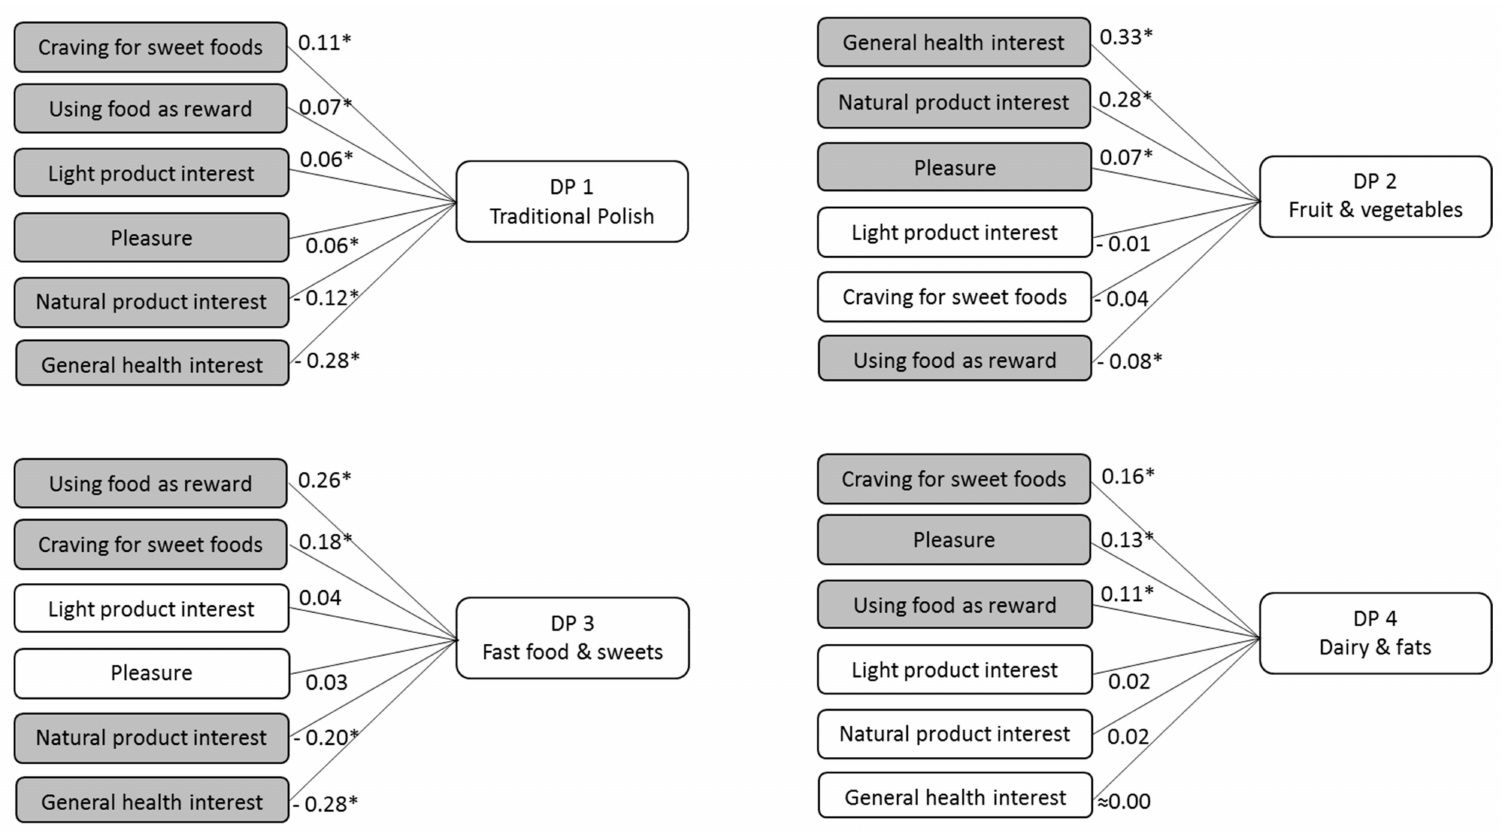
Figure 1. Spearman’s correlation coefficients for attitudes towards health and taste and dietary patterns (DPs) of girls and young women, the GEBaHealth Study ( n = 1107); All data adjusted for survey weights. Statistically significant: * p <